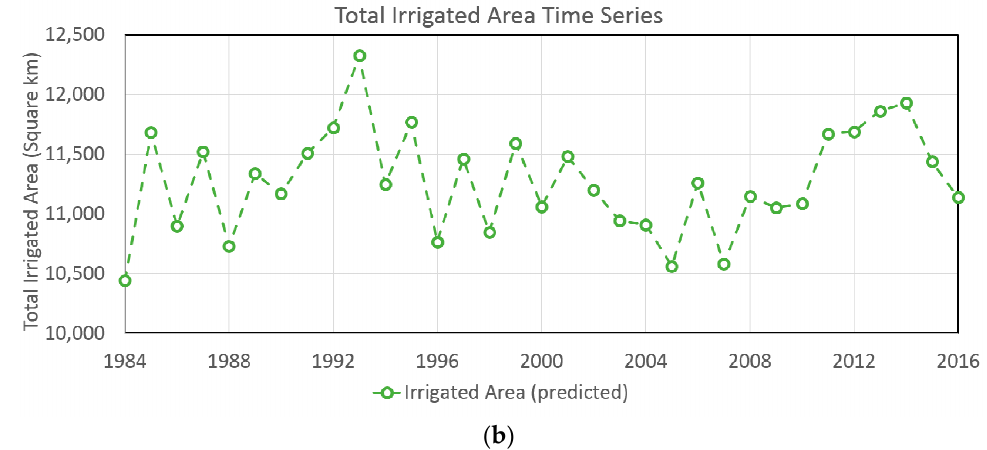
Figure 2. Time series plots. ( a ) displays mean Normalized Difference Moisture Index (NDMI) values across all pixels and separately for the irrigated and non-irrigated classes and the NDMI threshold used to distinguish irrigated from non-irrigated pixels. Blue and orange bands correspond to 95% confidence intervals for irrigated and non-irrigated NDMI values, respectively; ( b ) displays total irrigated land area within the study region by year.